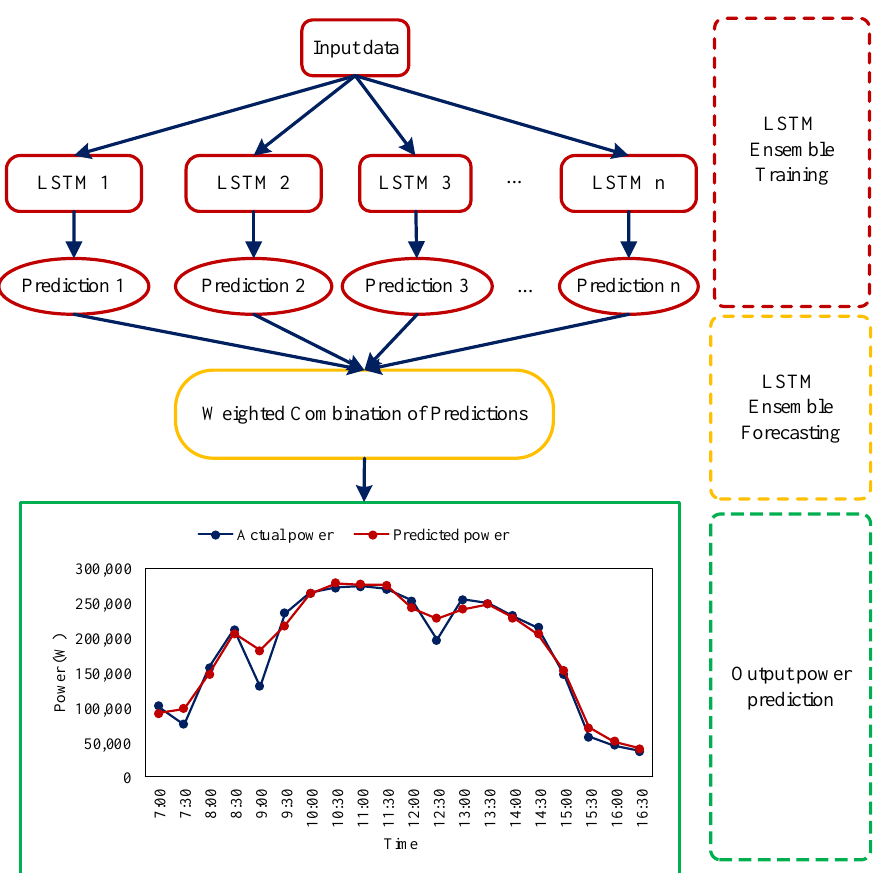
Figure 9. LSTM ensemble architecture.